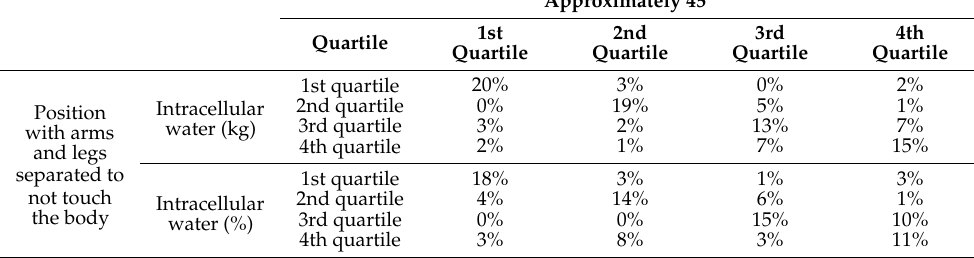
Table 6. Analysis of the quartile distribution of the muscle mass results in the studied group of Caucasian young normal body mass women measured in the follicular phase in various positions (with arms abducted at least 30 ◦ and legs abducted at approximately 45 ◦ ; with arms and legs separated to not touch the